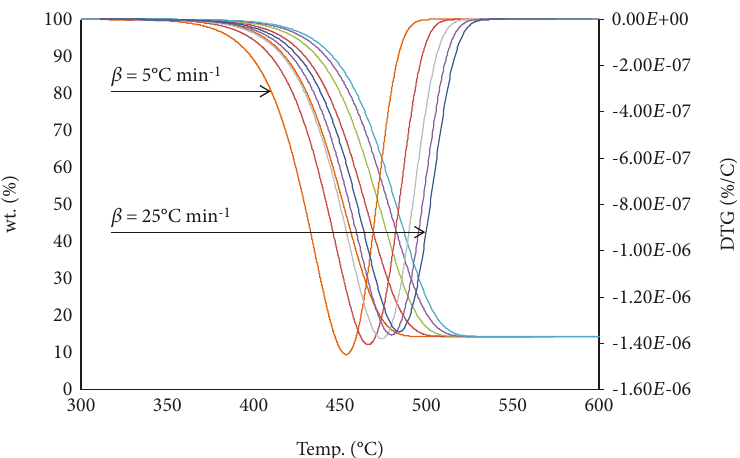
Figure 2: TGA thermogram showing weight loss and fi rst derivative of type I sample pre-exposure with respect to heating rates (5 to 25 ° C min -1 ) in sequential order (left to